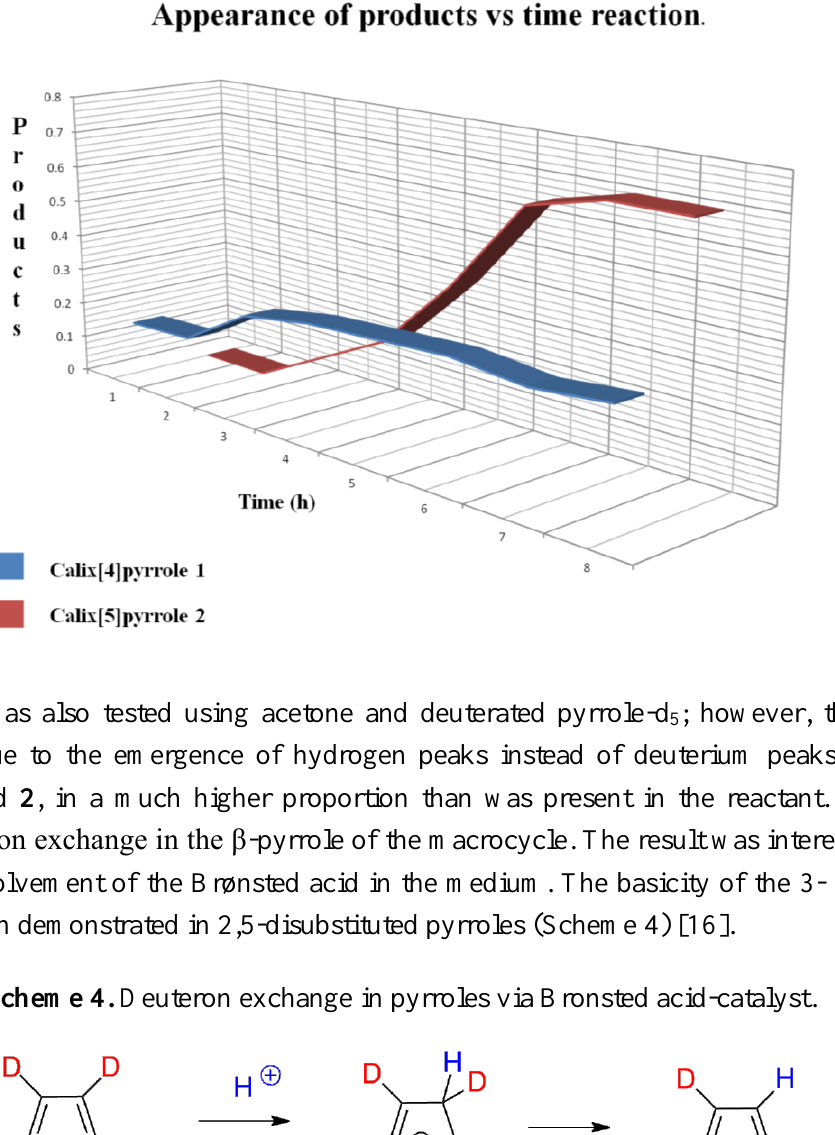
Figure 3. Progress of the reaction, showing the ratio of 1 to 2 obtained from the integrals of protons β as the reaction progressed (see Figure